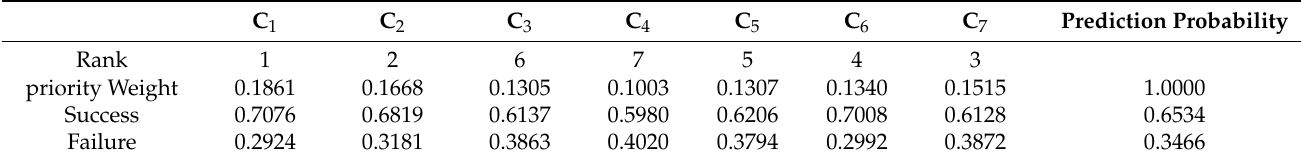
Table 15. Prediction of “success” and “failure” probabilities in